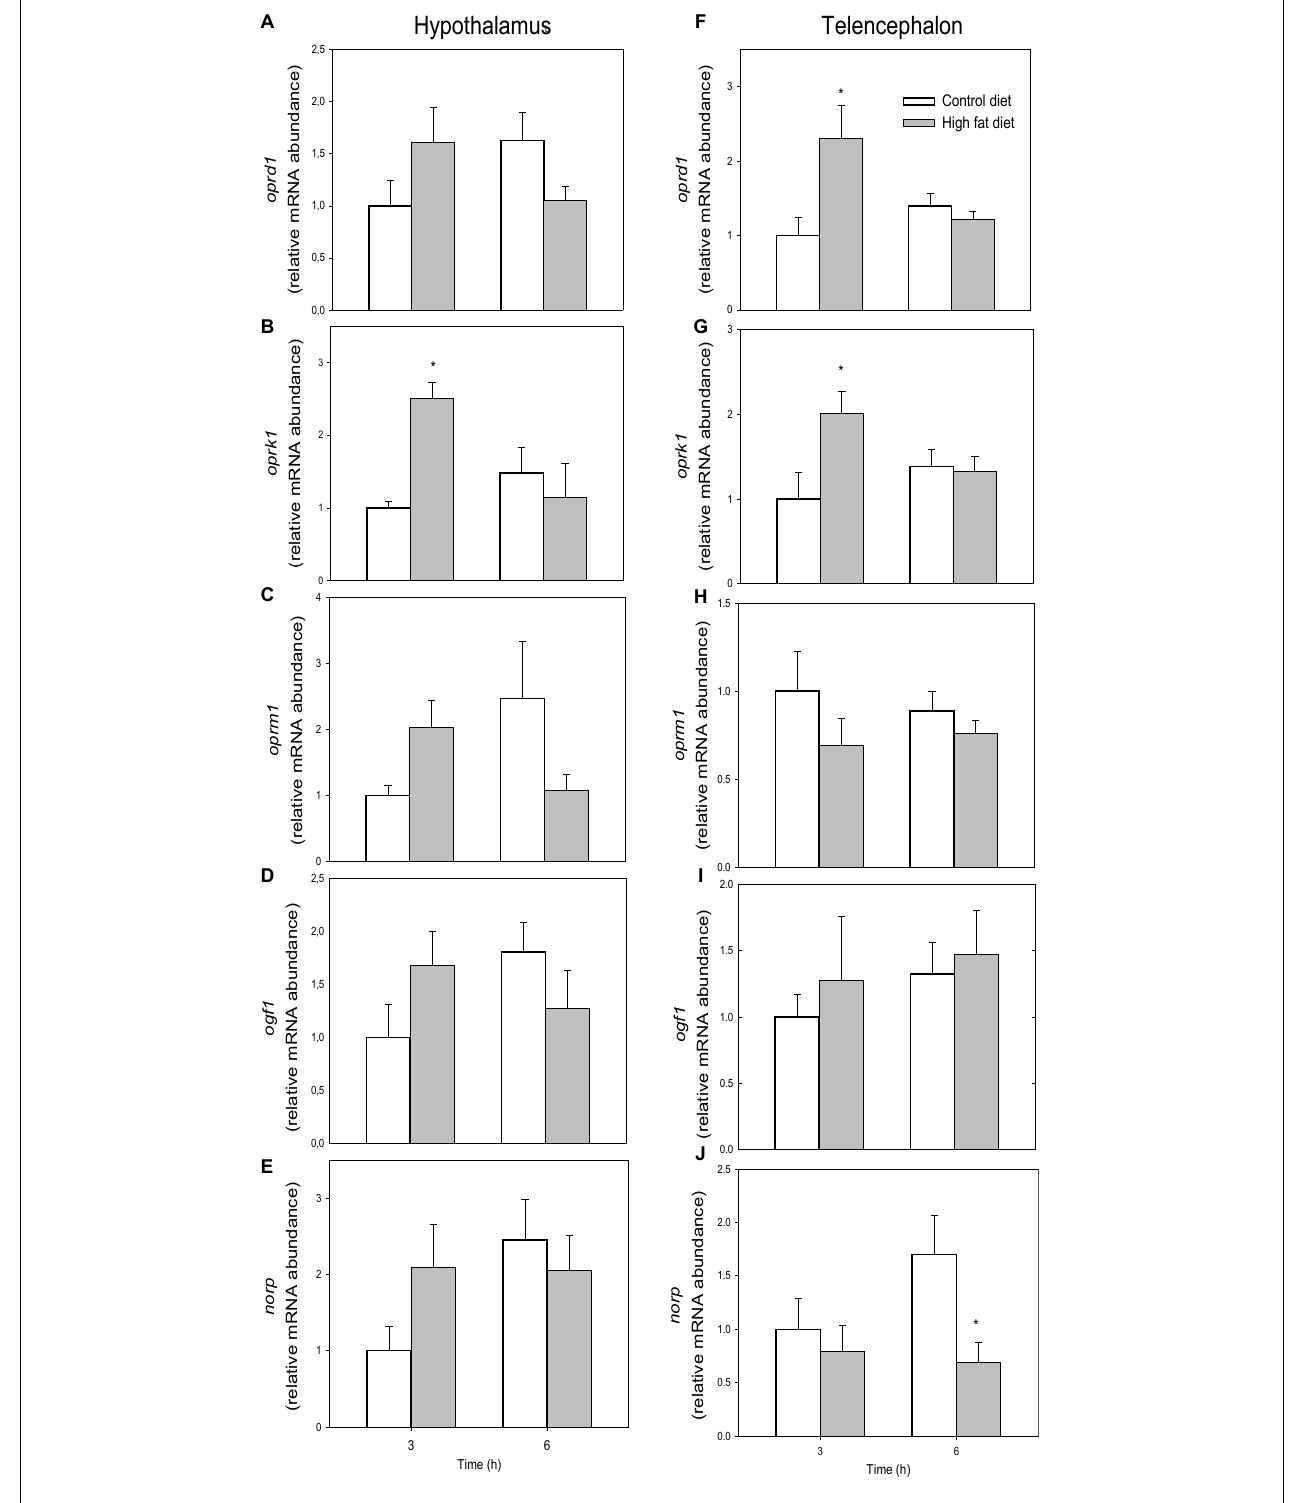
FIGURE 4 | mRNA abundance of oprd1 (A,F) , oprk1 (B,G) , oprm1 (C,H) , ogf1 (D,I) , and norp (E,J) in hypothalamus (A–E) and telencephalon (F–J) of rainbow trout fed with control diet (CD) or high-fat diet (HFD) sampled at different postfeeding times (3 and 6 h). Each value is the mean + S.E.M. of 6 fish. * Significantly different ( P < 0.05) from fish fed with CD at the same